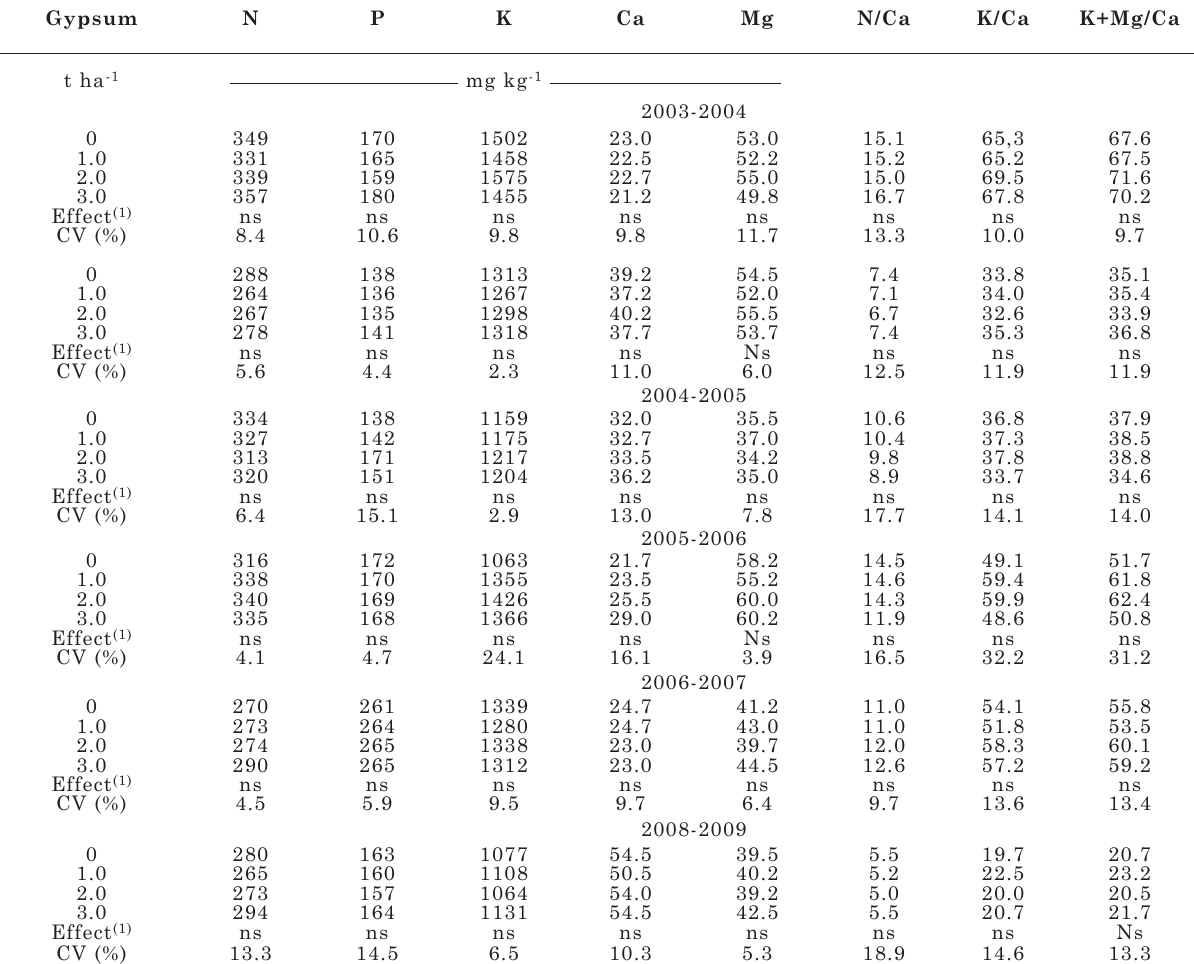
table 4. Concentrations of n, p, K, Ca, and mg in the fruit flesh and some ratios between them as affected by annual rates of gypsum applications broadcast on the soil surface, from 2001 to 2009 gypsum n p K Ca mg